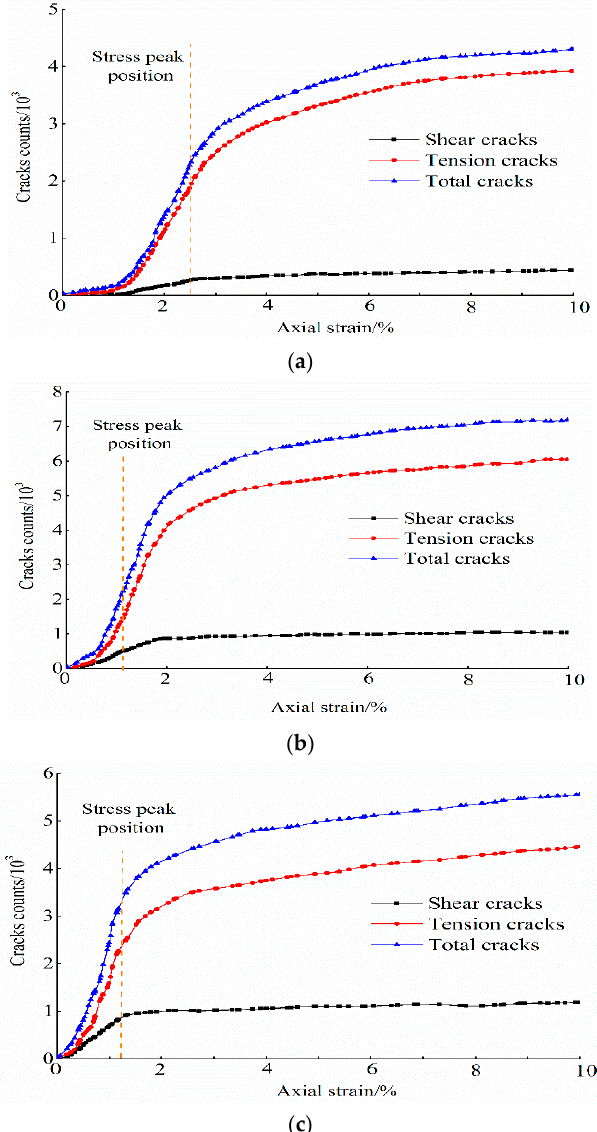
Figure 10. Relationship between the number of cracks and axial strain. ( a ) Test 1, ( b ) Test 2, ( c ) Test 3.